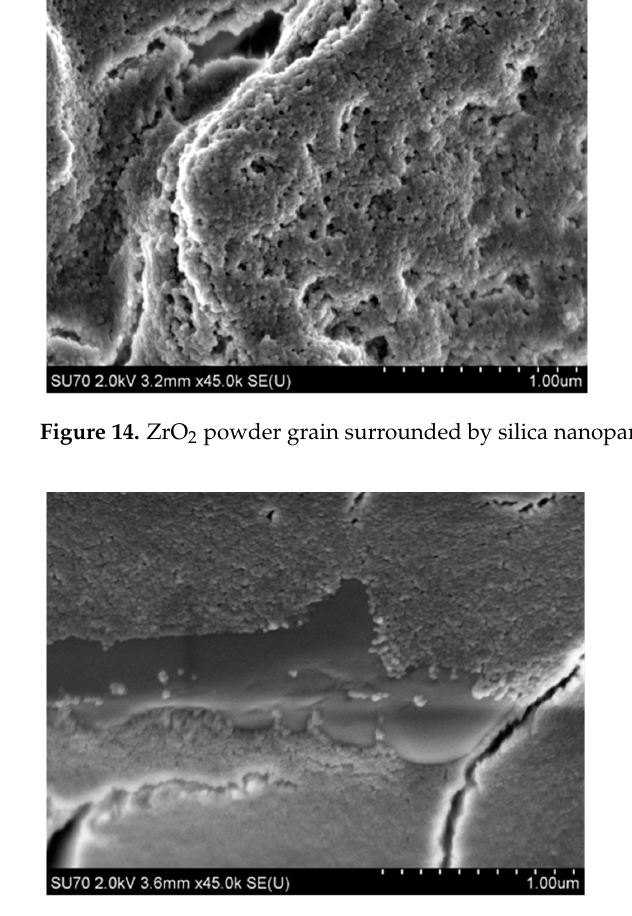
Figure 15. Morphology of the dried mixture of the Ludox AM-Al 2 O 3 system.